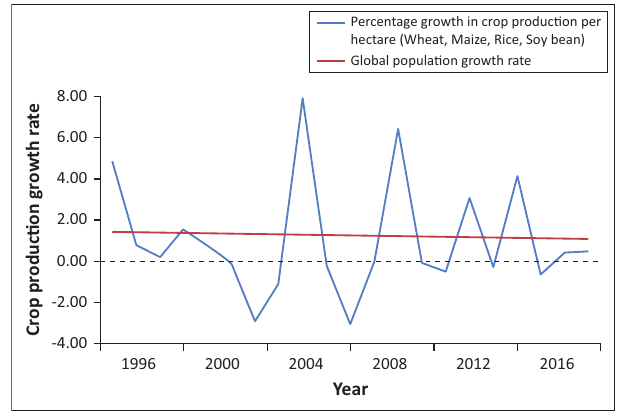
FIGURE 1: Carbon dioxide emissions and arable land.